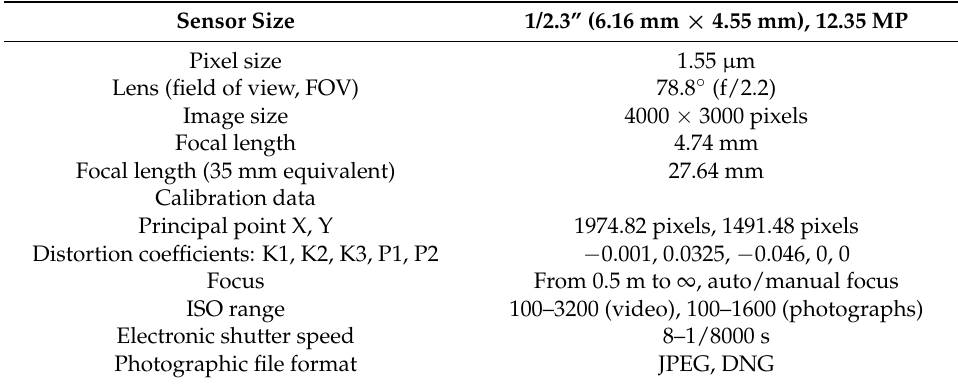
Table 5. DJI FC220 UAV camera sensor specifications.